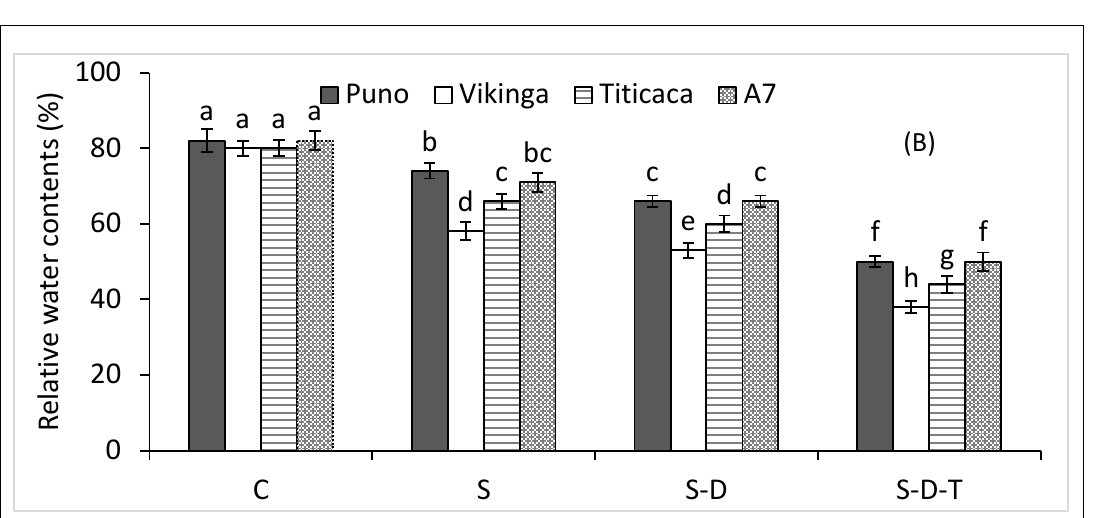
Figure 2. ( A ) Stomatal conductance and ( B ) relative water contents of quinoa genotypes under control (C), salinity (S), drought (D), and high-temperature (T) stress. S-D, combined salinity and drought treatment; S-D-T, combined salinity, drought, and high-temperature treatment. The values for each parameter are the means of three replicates ± SE. At the 5% probability level, bars with different letters indicate significant differences.